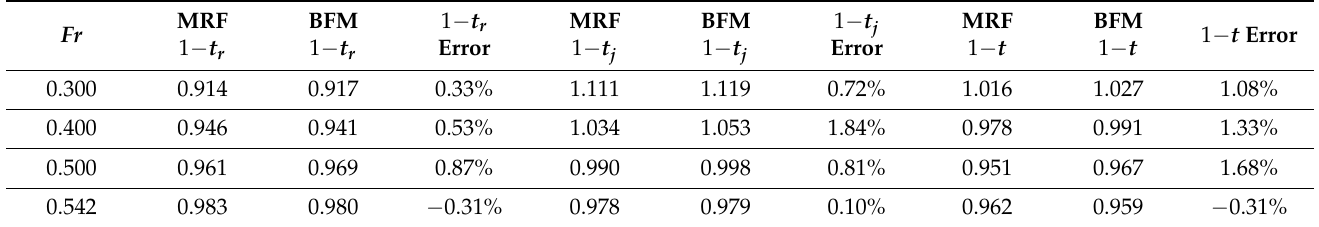
Table 7. Results of 1 − t r , 1 − t j and 1 − t with the MRF model and body-force model (BFM).